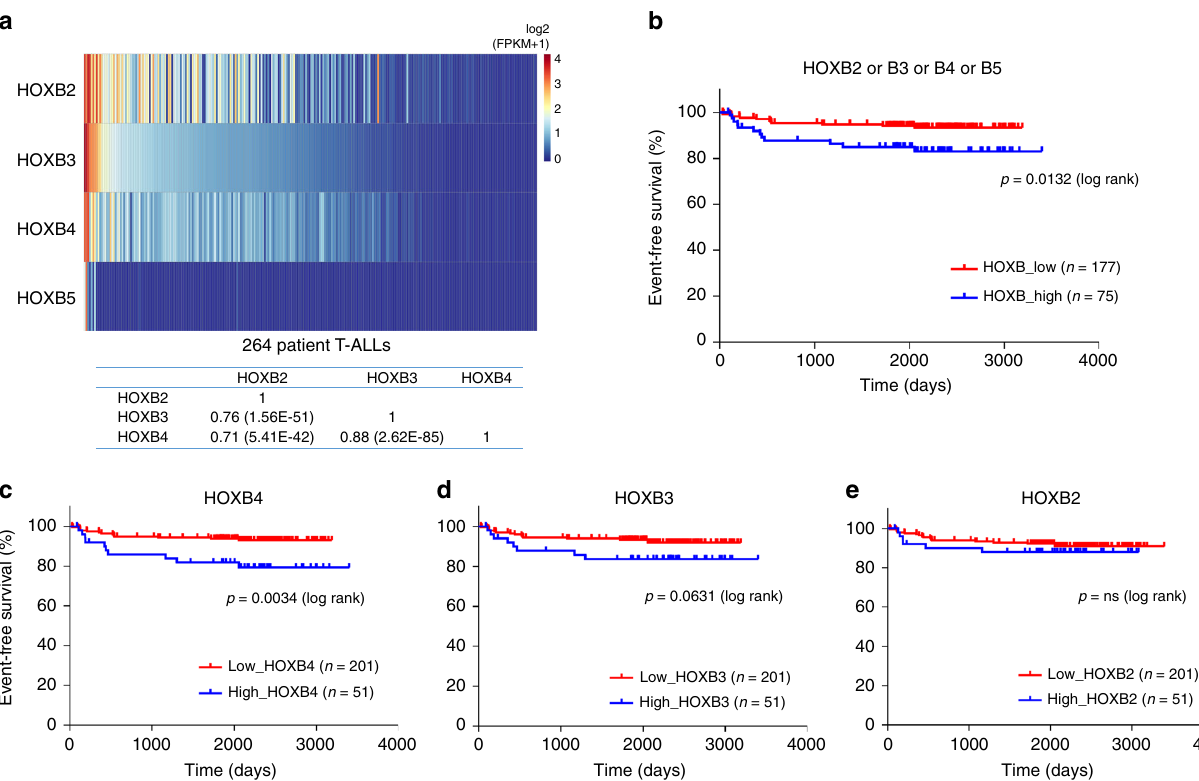
Fig. 6 High HOXB gene expression is associated with poor clinical outcome in human T-ALL. Analysis of 264 patient T-ALLs from the COG TARGET study (dbGaP phs00018/000464). a mRNA expression heatmap and Pearson correlation matrix. HOXB mRNA levels from RNA-seq data. Color scale is based on log2(FPKM + 1) values without further normalization. Samples are ordered left-to-right by decreasing HOXB3 level. Correlation p values are indicated in parentheses. b – e Event-free survival among 252 T-ALL patients. Twelve patients were excluded for withdrawn consent, second malignancy, or were inevaluable. b HOXB_high group. Cases were de fi ned as greater than 80th percentile mRNA level and FPKM > 1 for HOXB2, B3, B4, or B5. c HOXB4_high group. d HOXB3_high group. e HOXB2_high group. The HOXB5_high group included only three cases and thus was not plotted. ns not signi fi